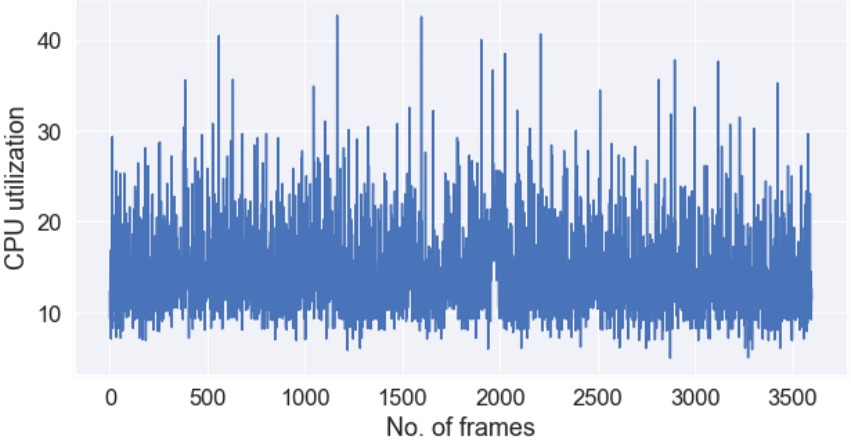
Figure 33. CPU utilization in